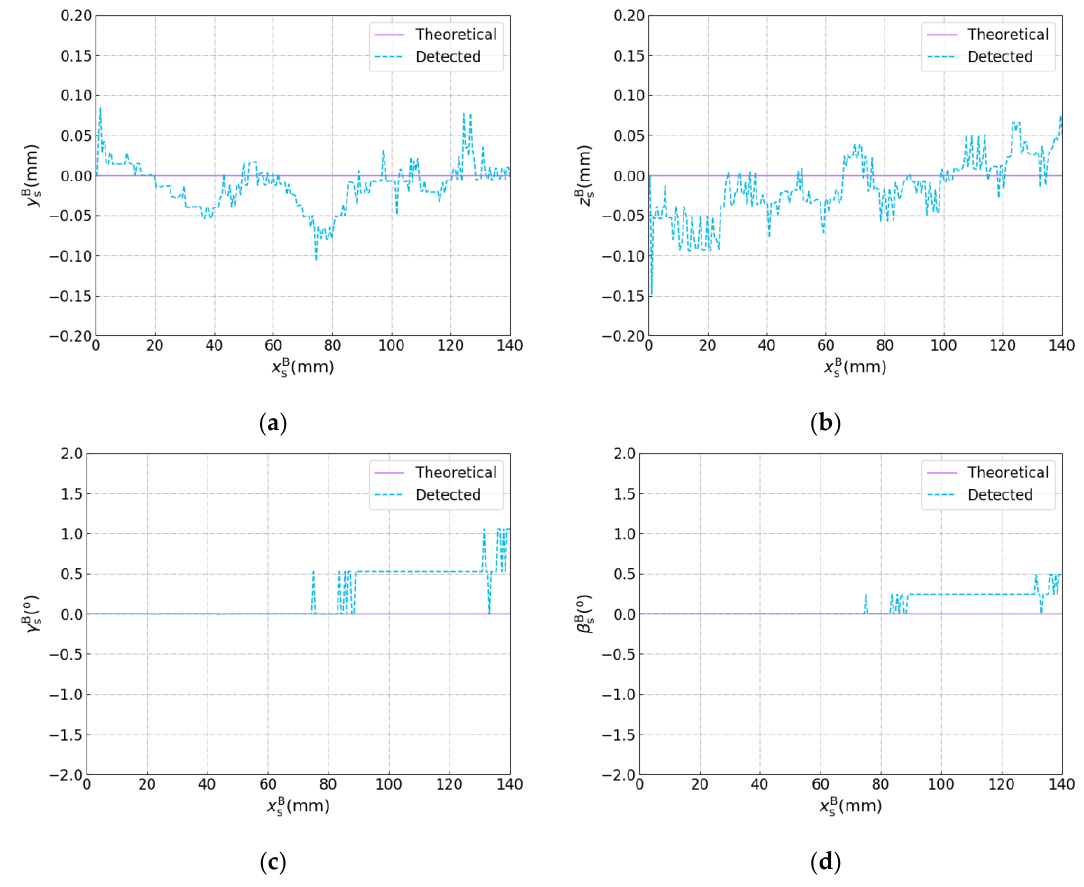
Figure 16. Results of the joint detection experiment with the plane workpieces. ( a ) 𝑦 sB versus 𝑥 sB . ( b ) 𝑧 sB versus 𝑥 sB . ( c ) 𝛾 sB versus 𝑥 sB . ( d ) 𝛽 sB versus 𝑥 sB